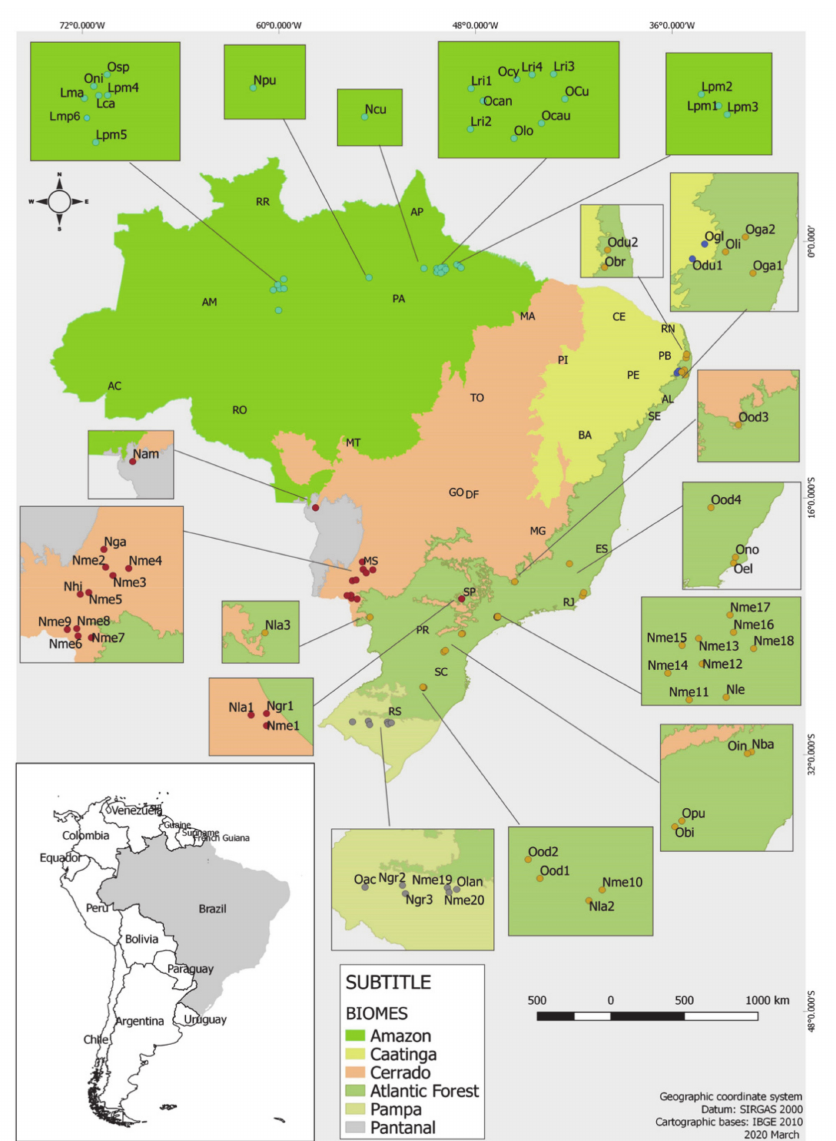
Figure 1. Geographical distribution in Brazilian biomes of Licaria , Nectandra , and Ocotea specimens based on its studies of essential oils. This map was built by the authors using the information of the collection site available in the bibliographic reference to each access. Licaria canella : (Lca); L. martiniana : (Lma), L. puchury-major (Lpm1, Lpm2, Lpm3, Lpm4, Lpm5, Lpm6); L. rigida (Lri1, Lr2, Lr3, Lri4), Nectandra amazonum (Nam), N. barbellata (Nba), N. cuspidata (Ncu), N. gardneri (Nga), N. grandiflora (Ngr1, Ngr2, Ngr3), N. hihua (Nhi), N. lanceolata ( Nla1, Nla2, Nla3), N. leucantha (Nle), N. megapotamica ( Nme1, Nme2, Nme3, Nme4, Nme5, Nme6, Nme7, Nme8, Nme9, Nme10, Nme11, Nme12, Nme13, Nme14, Nme15, Nme16, Nme17, Nme18, Nme19, Nme20), N. puberula (Npu), Ocotea caniculata (Ocan), O. caudata (Ocau), O. cujumary (Ocu), O. cymbarum (Ocy), O. duckei (Odu1, Odu2), O. glomerata (Ogl), O. longif ó lia (Olo), O. nigrescen (Oni), O. splendens (Osp), O. bicolor (Obi), O. bracteosa (Obr), O. elegans (Oel), O. indecora (Oin), O. gardneri (Oga1, Oga2), O. limae (Oli), O. notata (Ono), O. odor í fera (Ood1, Ood2, Ood3, Ood4), O. puberula (Opu), O. acutif ó lia (Oac), O. lancifolia (Olan). Abbreviation